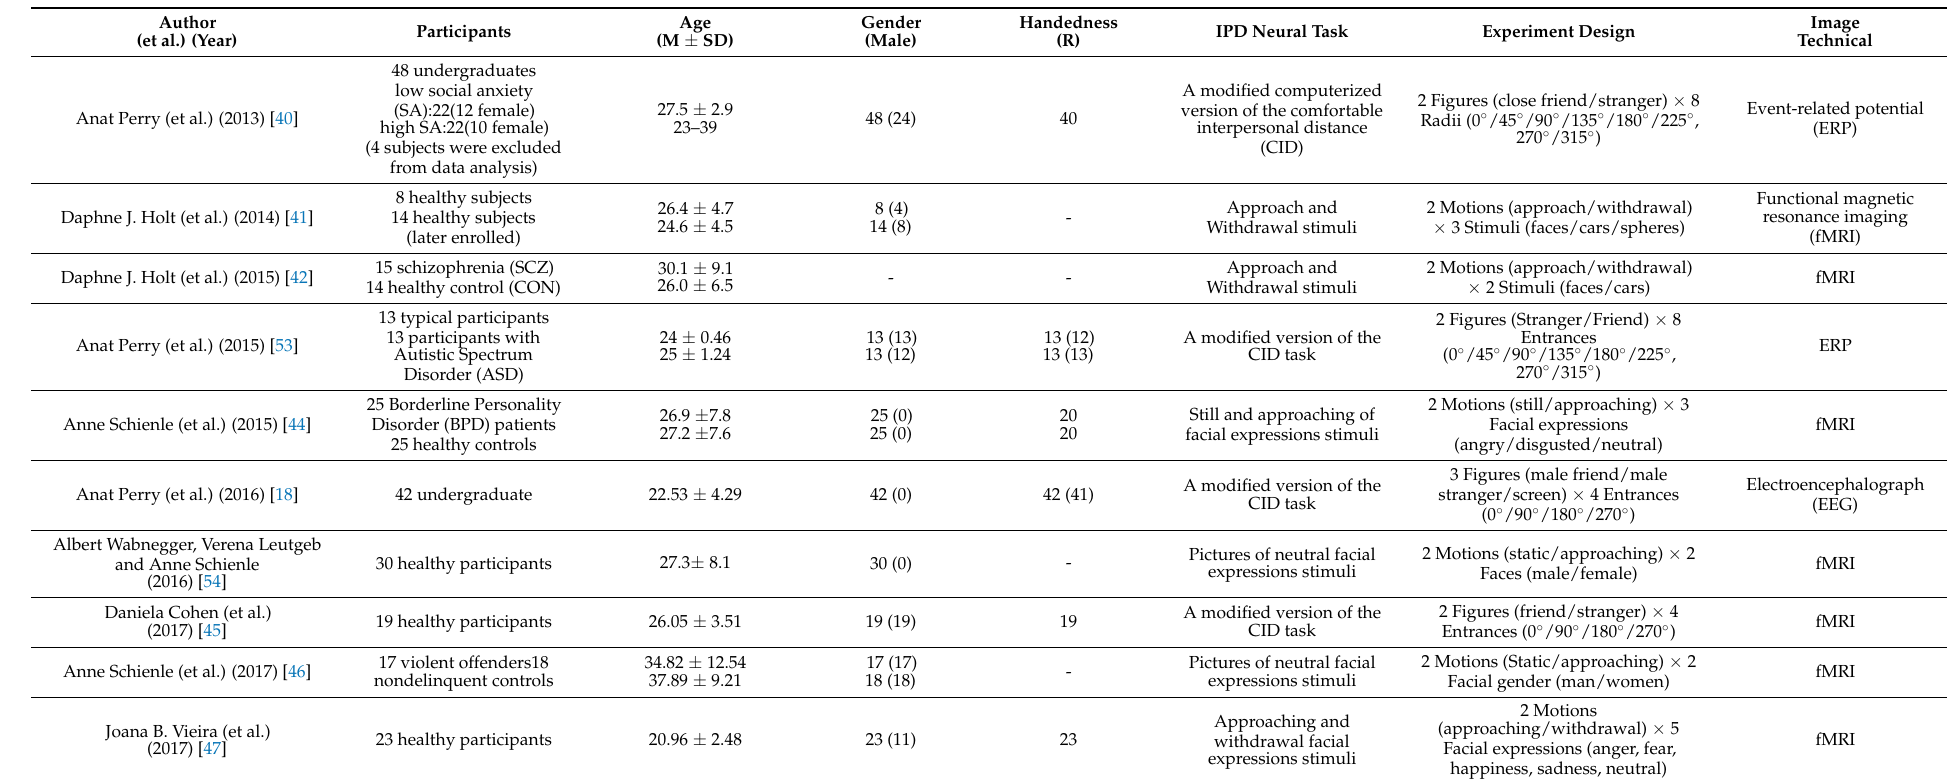
Table 1. Basic information and study design for the included